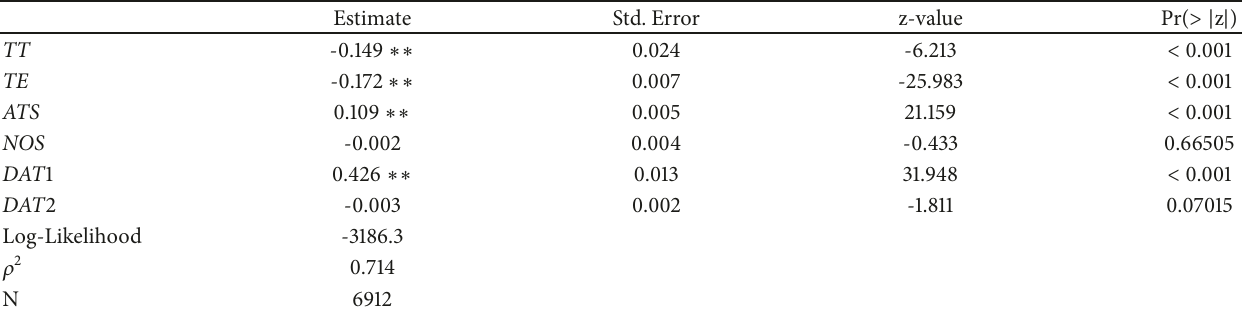
Table 4: Results of the multinomial logit